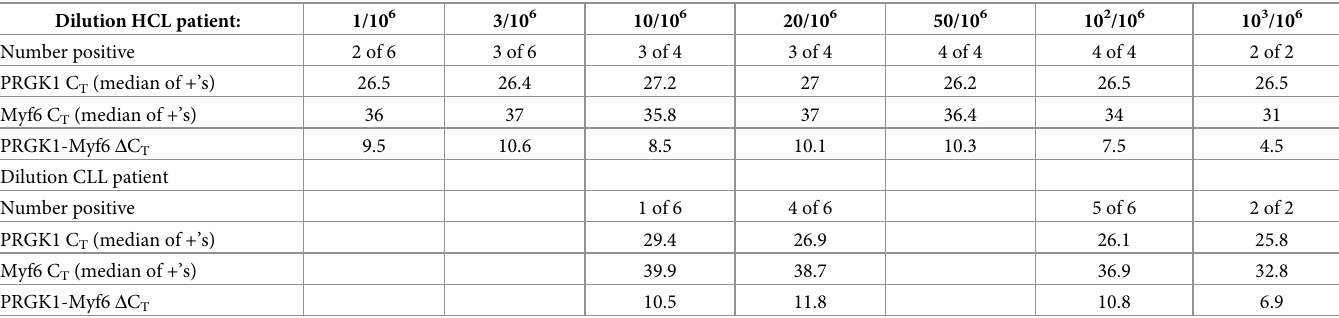
Table 6. Sensitivity of Myf6 detection in CLL and HCL.